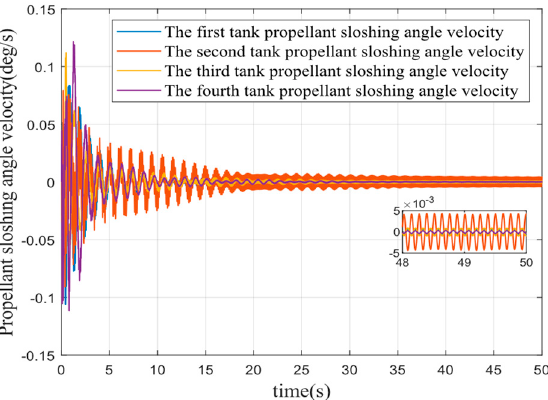
Figure 20. Angular velocity of liquid fuel shaking without considering external disturbances.